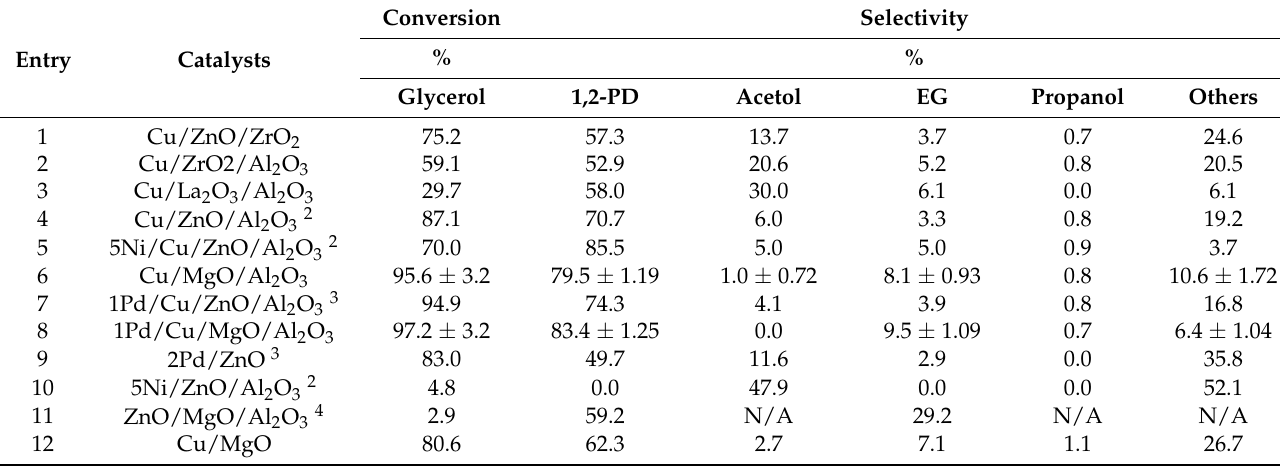
Table 1. Conversions of glycerol and selectivities of products using the catalysts with different metal combinations 1